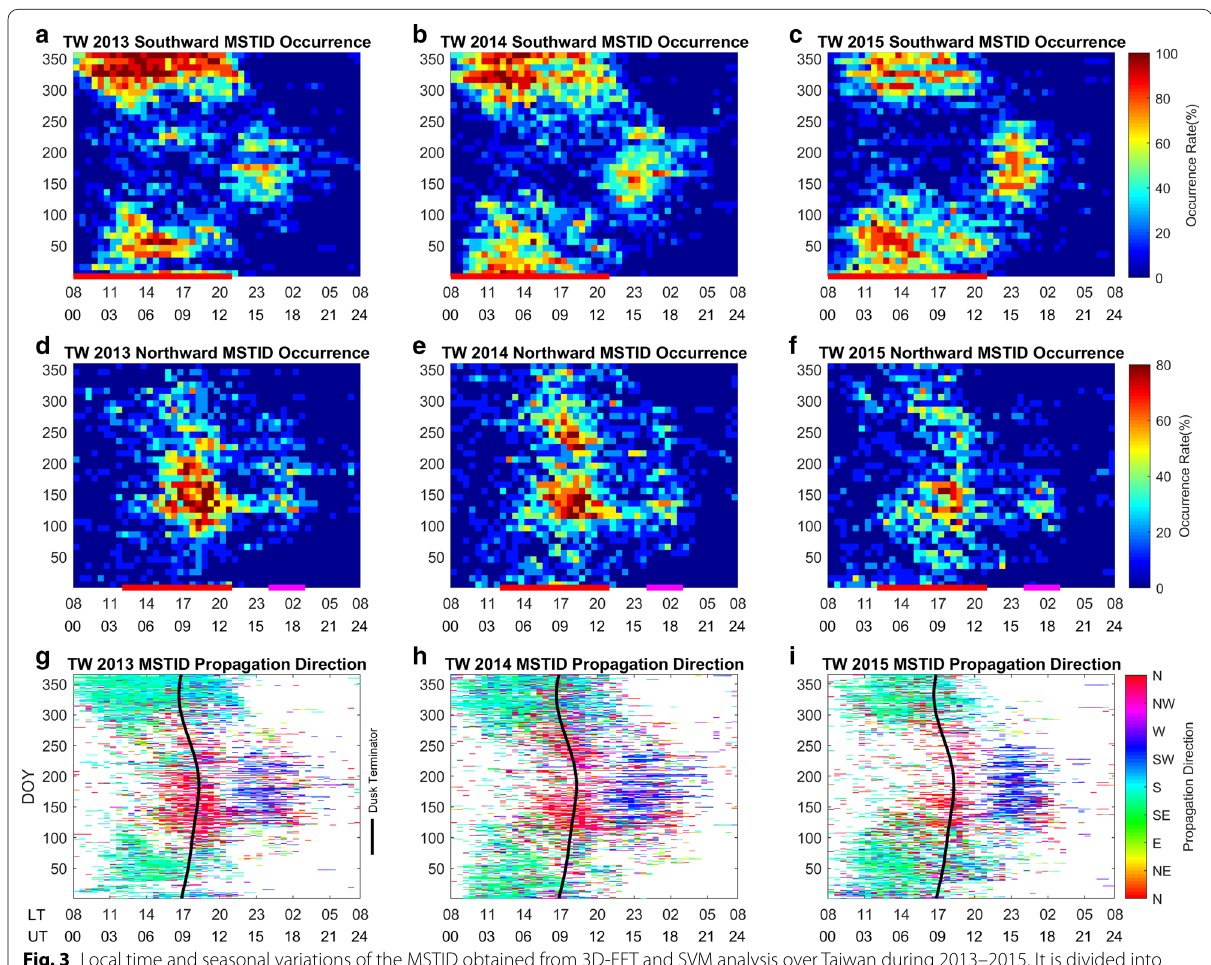
Fig. 3 Local time and seasonal variations of the MSTID obtained from 3D‑FFT and SVM analysis over Taiwan during 2013–2015. It is divided into 10 days and half an hour per grid for calculating the occurrence rate of southward MSTIDs in a 2013, b 2014, c 2015 year and northward MSTIDs in d 2013, e 2014, f 2015 year. The propagation direction of MSTIDs is compared to the dusk terminator (black line) in g 2013, h 2014, i 2015